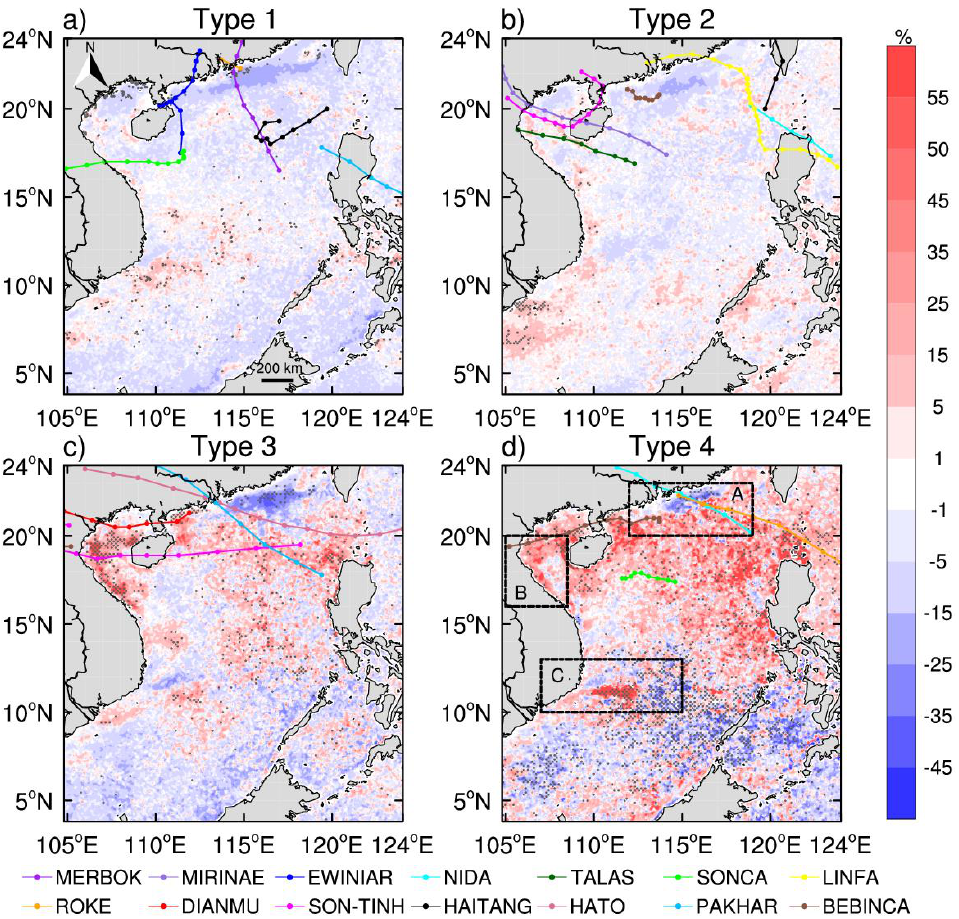
Figure 12. The chl-a concentration percentage of the four synoptic types under the effect of typhoons and superimposed typhoon paths): ( a ) Type 1; ( b ) Type 2; ( c ) Type 3; ( d ) Type 4.